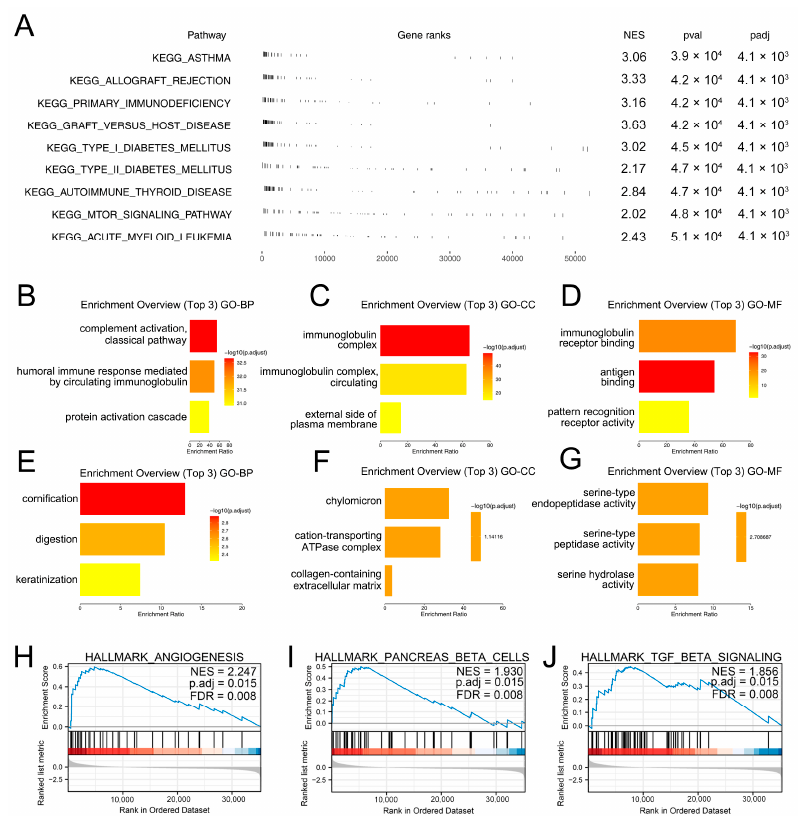
Figure 5. The biological role of TMIGD3. Notes: ( A ) GSEA analysis based on the KEGG gene set; ( B – G ) GO analysis of TMIGD3; ( H – J ) GSEA analysis based on Hallmark gene set (the red color under the black line represents the gene has a promoting effect on the activity of this pathway, while blue color has the opposite e ff ect).